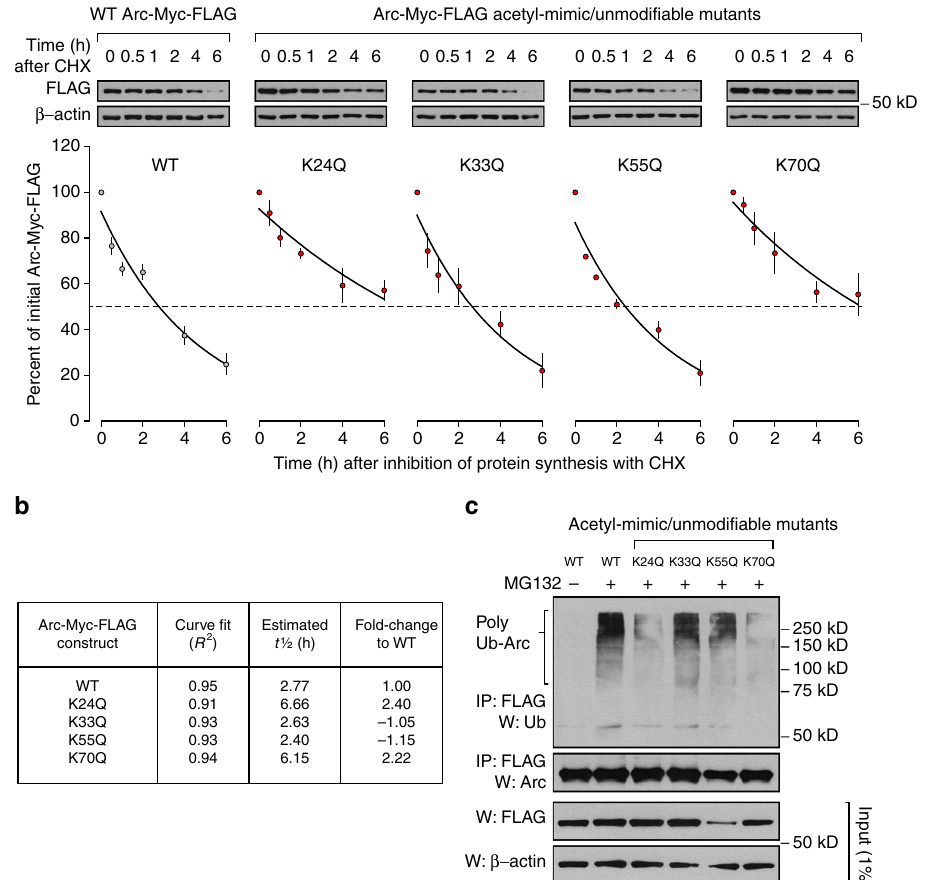
Fig. 7 K24 and K70 contribute to Arc protein stability. a Mouse WT and acetyl-mimic mutants (K24Q, K33Q, K55Q, K70Q) Arc-Myc-FLAG were overexpressed in different Neuro2a cultures for 16 h at which point cells were treated with CHX (50 µ g ml − 1 ) to block protein synthesis. Lysates were collected at the indicated time points and Arc-Myc-FLAG protein level analyzed in every sample by western blotting with an anti-FLAG antibody. Representative western blots are presented on top and quanti fi cation of data normalized to corresponding β -actin and presented as percentage of Arc- Myc-FLAG level ( ± SEM) at the initial time point after CHX application ( t = 0). Curve represents exponential decay fi t. b Estimate of protein half-life Arc for WT Arc-Myc-FLAG and each acetyl-mimic mutant is presented in table. c WT and acetyl-mutant Arc-Myc-FLAG polyubiquitination was determined in lysates from overexpressing Neuro2a cells. Lysates were immunoprecipitated with anti-FLAG and western blotted with anti-Ub or anti-Arc as indicated. The proteasome inhibitor MG132 (10 µ M) was added for 20 min before preparation of lysates to allow accumulation of polyubiquitinated